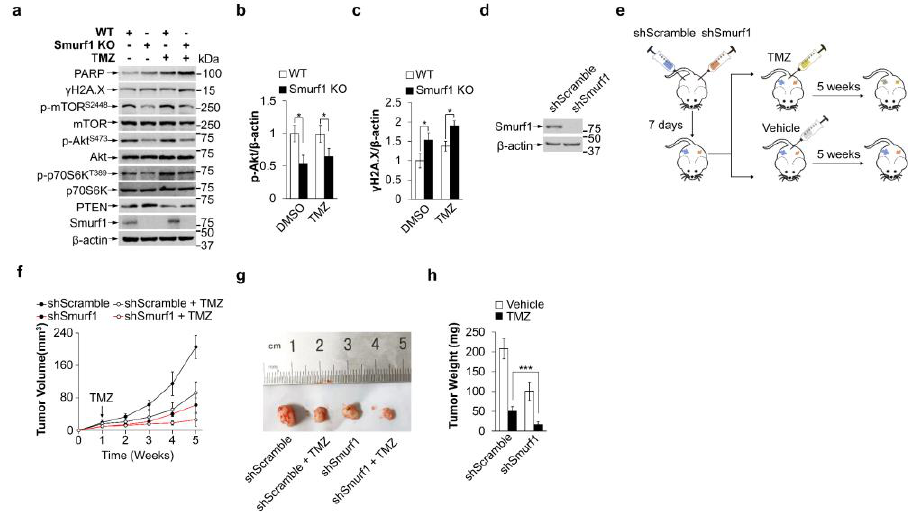
Figure 4. Smurf1 knockout restores sensitivity of PTEN wild − type GB cells to TMZ. ( a – c ) The